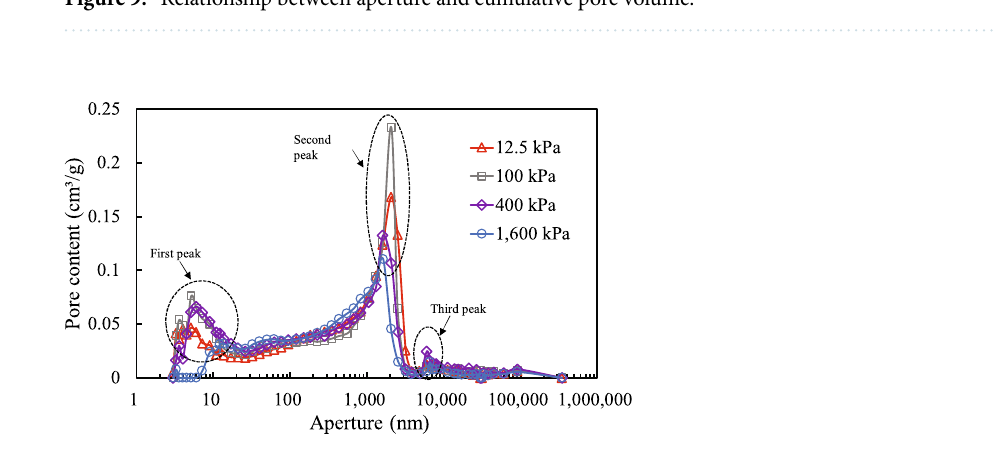
Figure 10. Relationship between aperture and pore content.